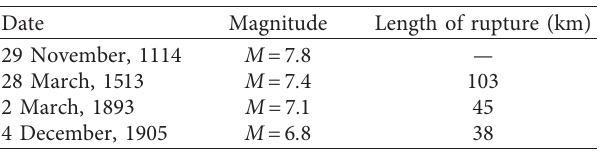
Figure 1: Geological map of the Kahramanmaras area [16]. Table 1: Earthquake events took place on Golbası-Turkoglu seg- ment [16, 22, 38,